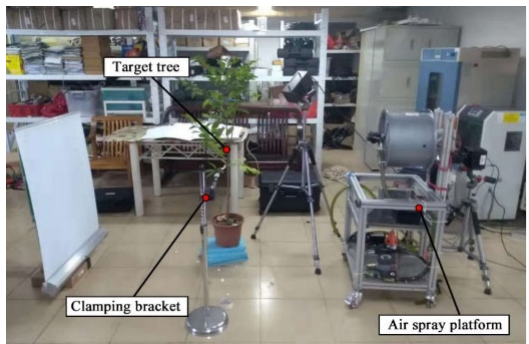
Experimental Factors Parameters